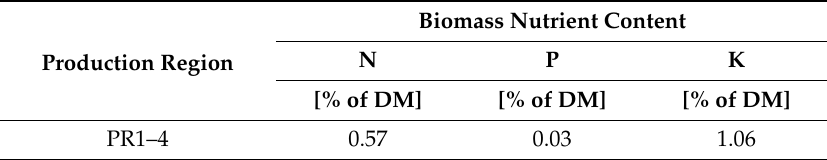
Table A2. Nutrient content of winter wheat straw [27] used to calculate plant nutrients